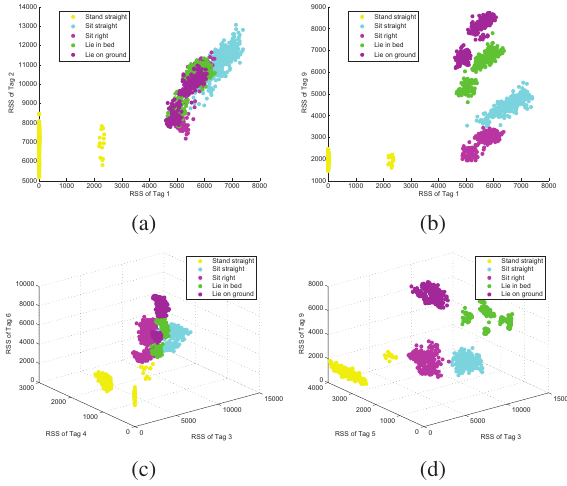
Figure 6: Illustrative examples of tag correlations the optimal tag array configuration in our